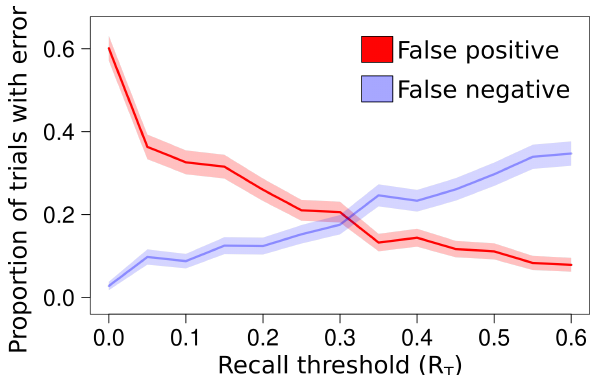
Figure 11. Impact of the recall threshold R T on the retrieval of information in the collective memory. The quorum responses of the robots in two different configurations, mixed or segregated aggregates, are tested for different values of R T . For each configuration and each tested value, 1000 simulations are performed. When R T is low, robots will have higher chances to consider that their configuration is segregated based on their local observations. Therefore, lower R T values increase the risk of false positives when robots are in mixed configuration. Conversely, when R T is high, robots have higher chances to detect a mixed configuration. Higher R T values increase the risk of false negatives in which the group fails to detect a segregated configuration. In addition, 95% confidence intervals are displayed around the proportion of errors in the experiments.